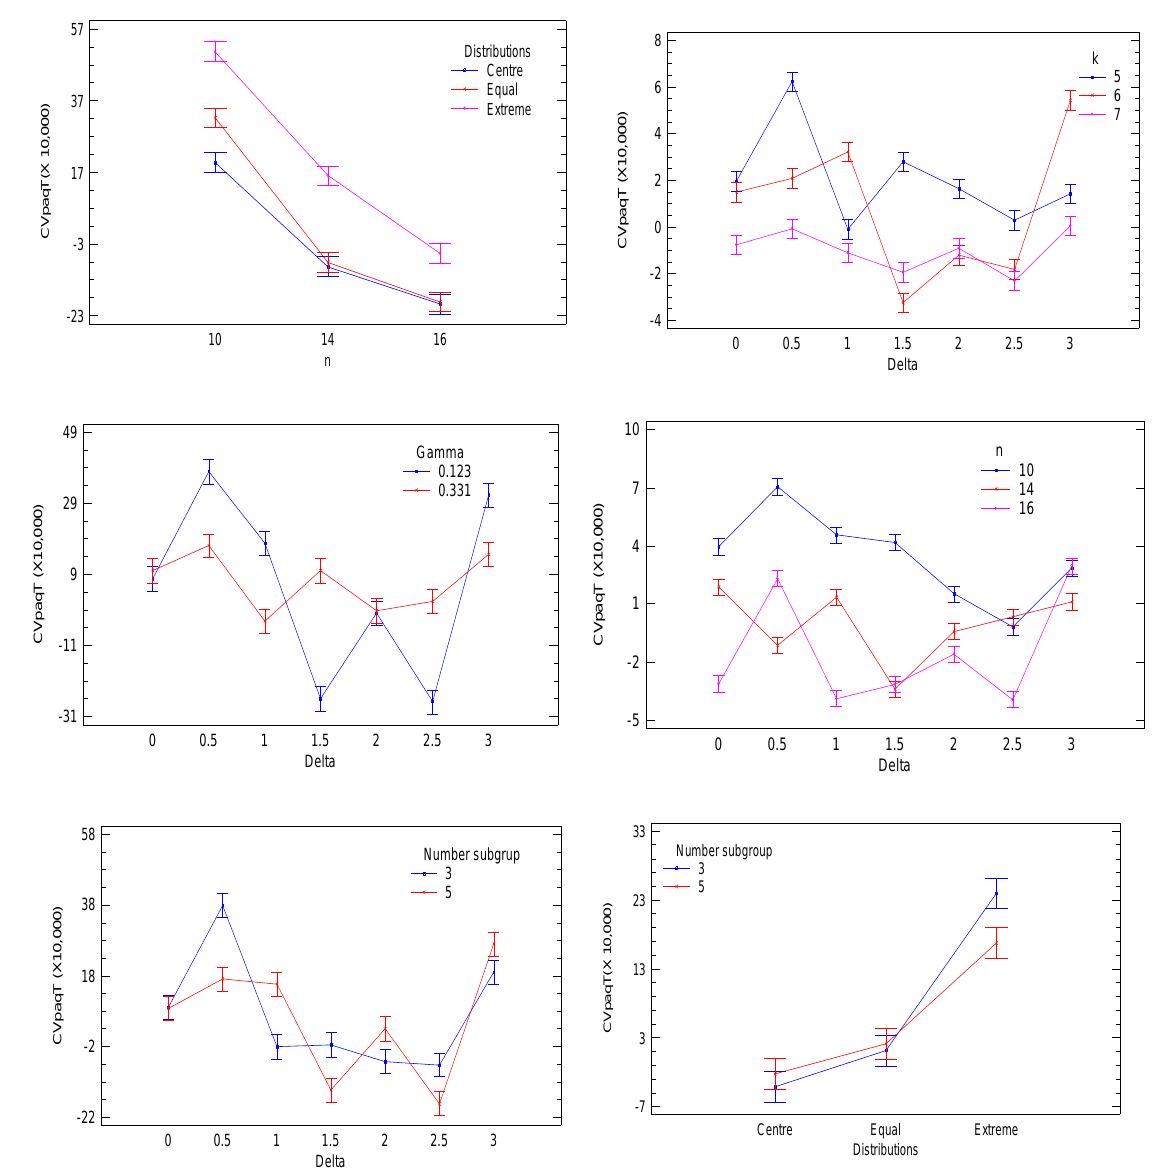
Figure 9. Significant interactions between factors for the CVpaqT (II) variable.